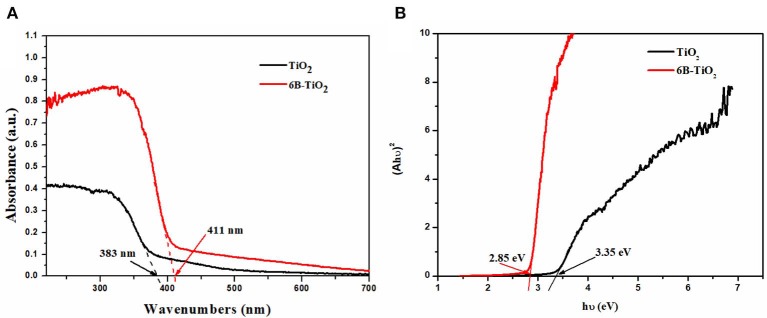
(A) Uv-vis DRS and (B) Tauc plot of bare TiO2 and 6B-TiO2.